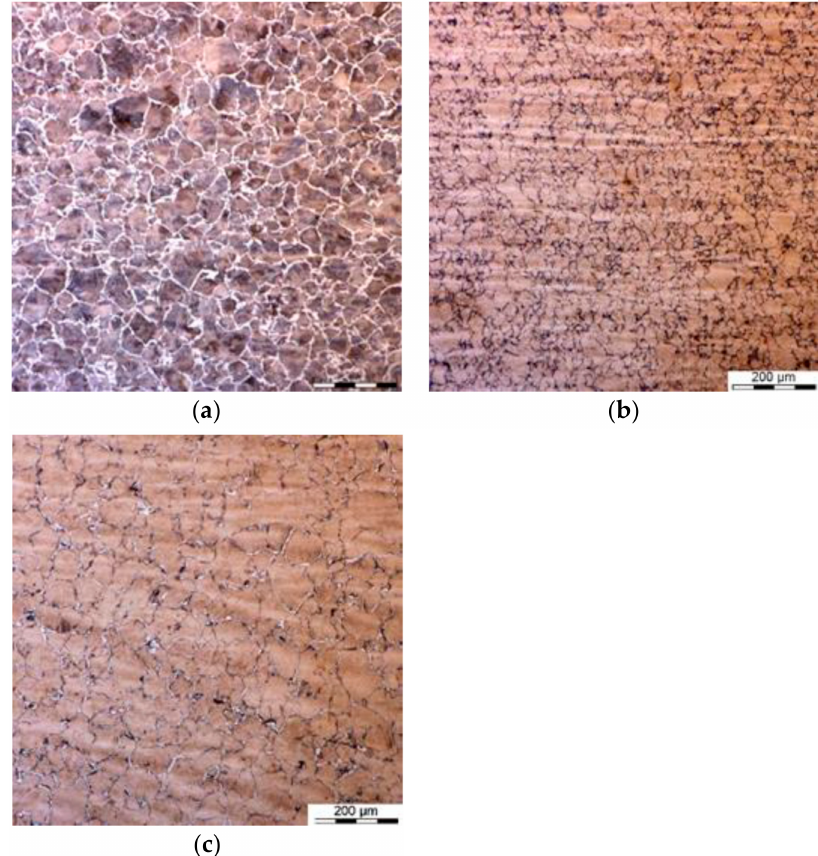
Figure 9. Point P variant 1—microstructures of the samples after first cooling to 540 ◦ C ( a ), after heat- ing to the holding temperature ( b ) and at the end of holding ( c